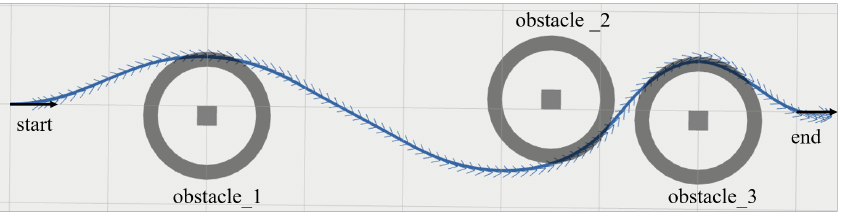
Figure 8. The trajectory generated by NRTEB. The curve is the motion trajectory and the arrows represent the heading angle of the planning state.